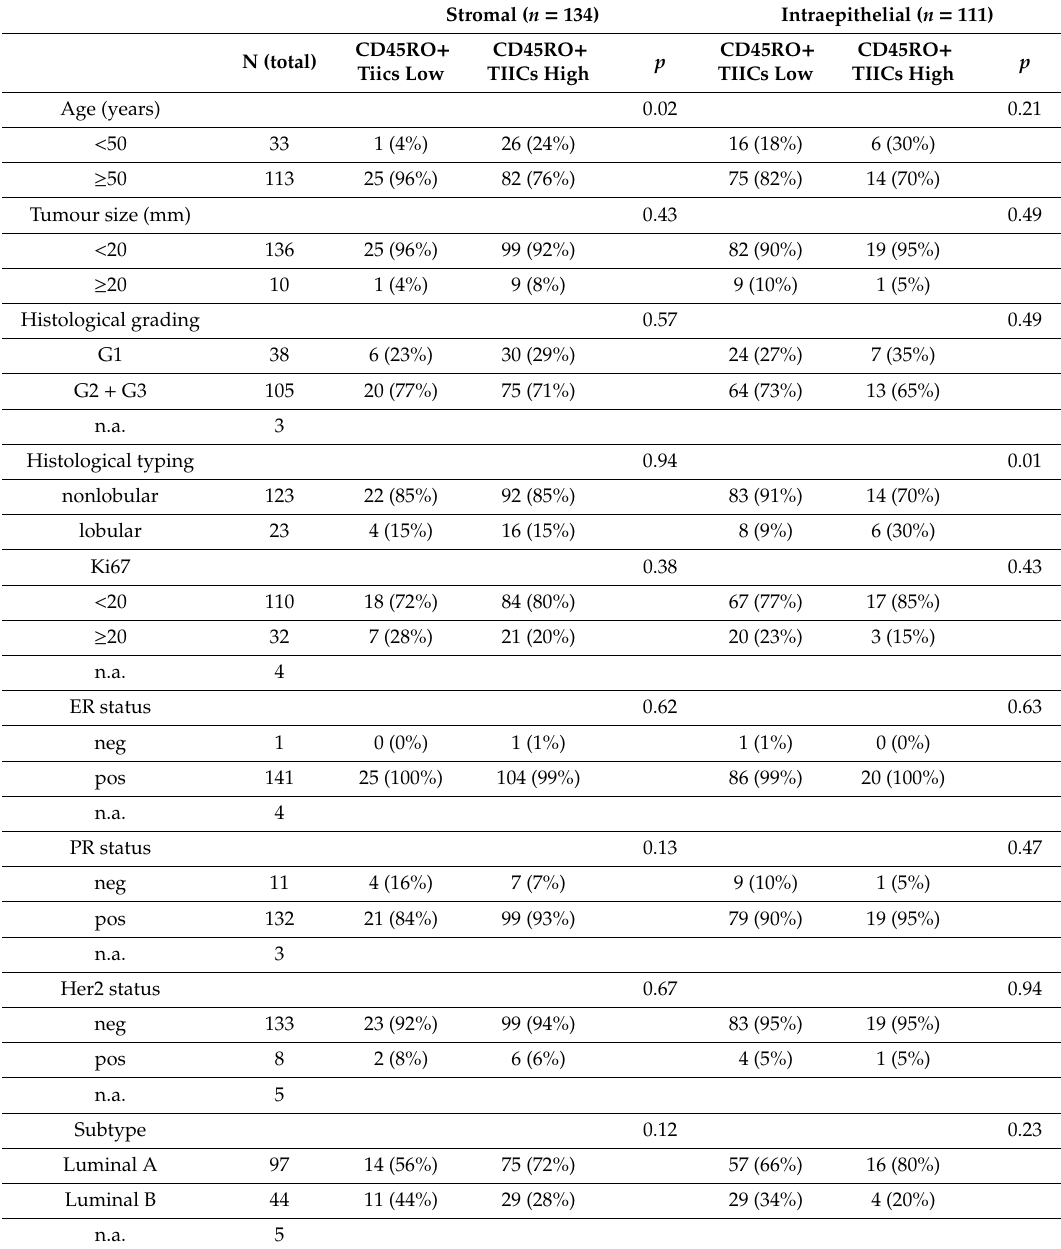
Table 3. Correlations between clinicopathological characteristics and CD45RO + TIICs in both tumour compartments of invasive front